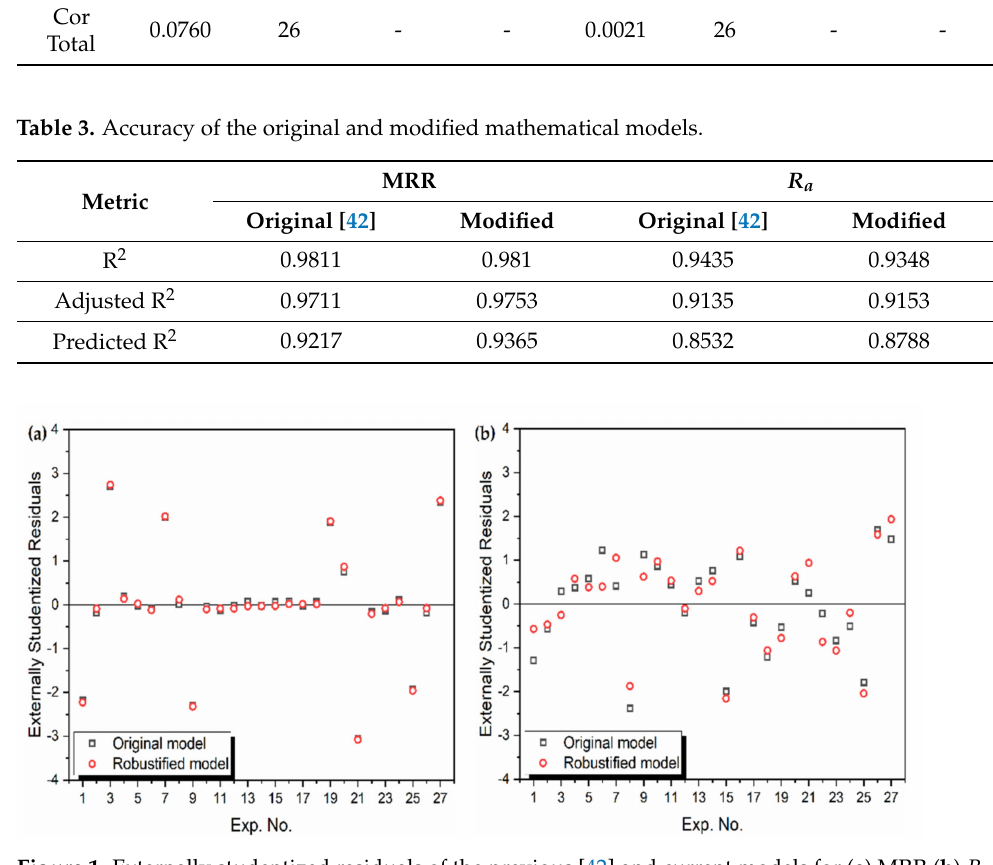
Figure 1. Externally studentized residuals of the previous [42] and current models for ( a ) MRR ( b ) R a